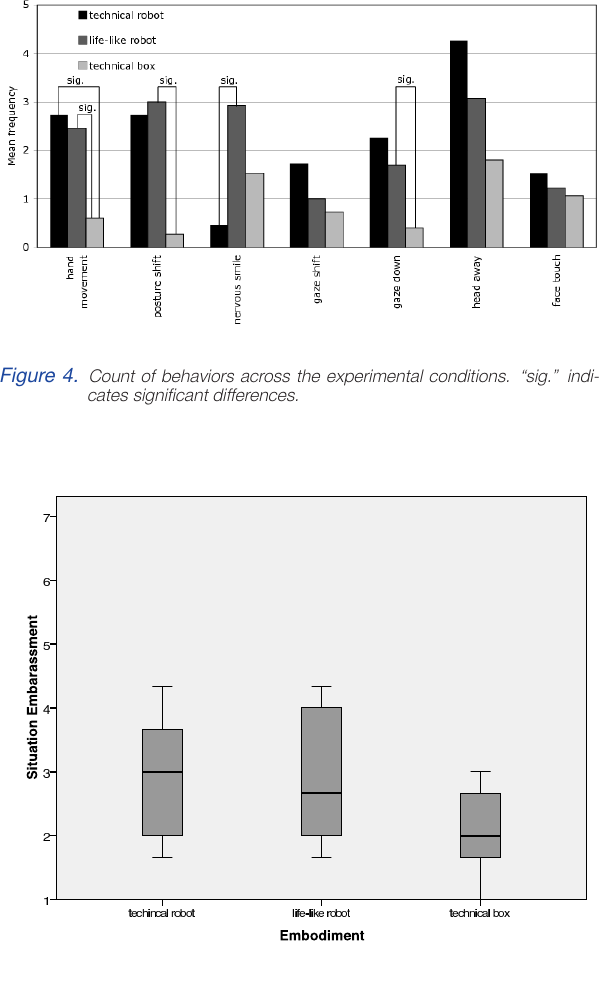
Figure 5. Situation Embarrassment across the embodiment